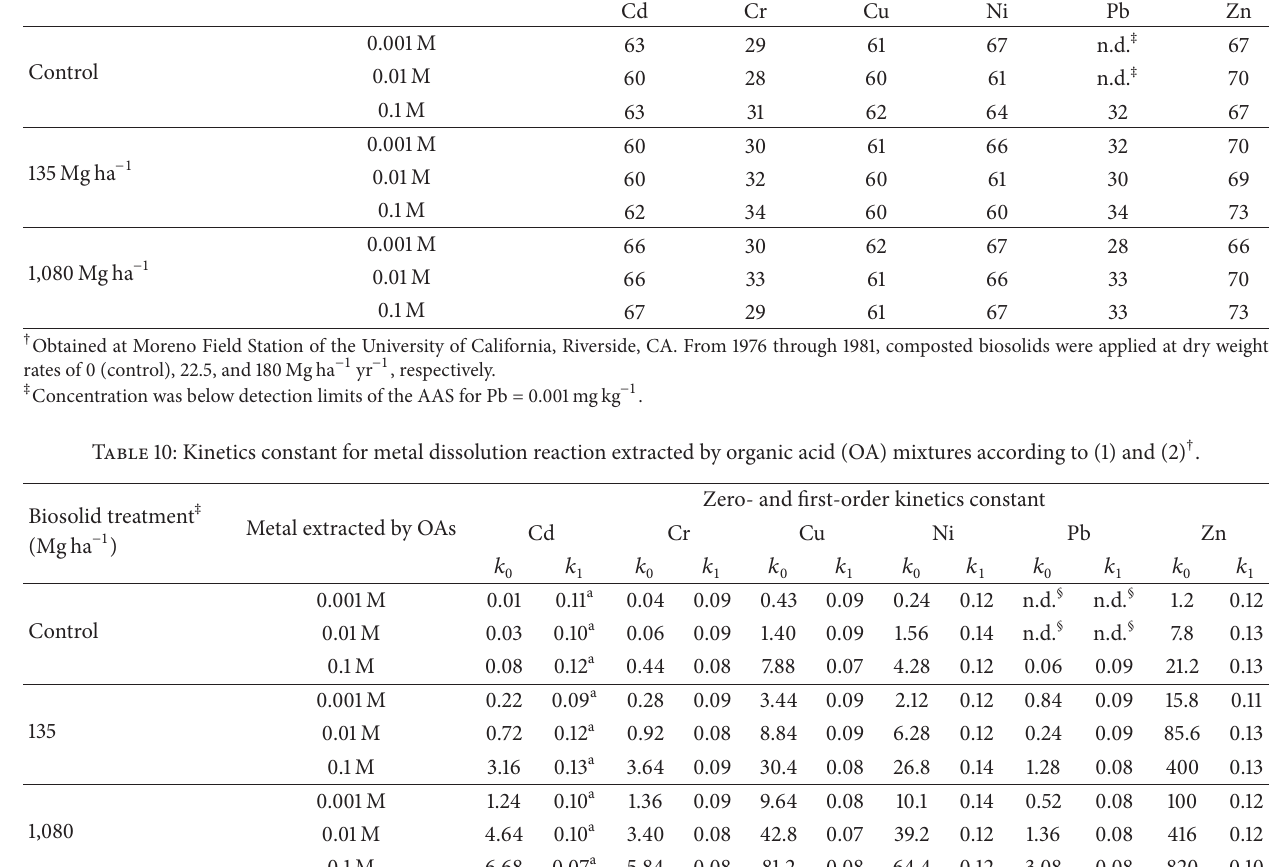
Table 9: Metals of control and biosolid-treated soils solubilized by organic acid (OA) mixtures in the first 15 minutes of equilibration. Biosolid treatment † Concentration of OA mixtures